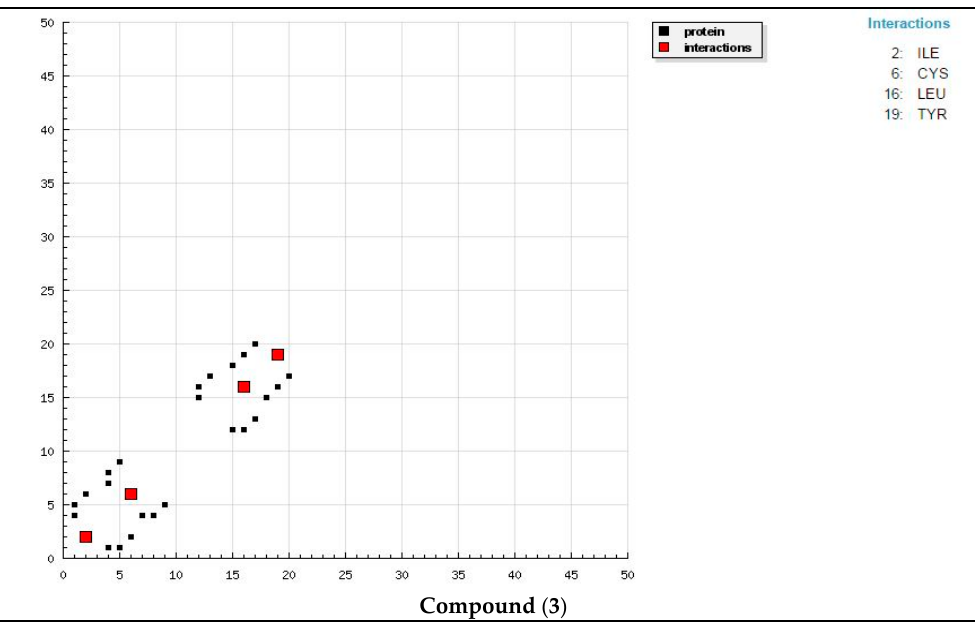
Figure 6. HB plot of interaction between spiropyrazoles products with receptor of breast cancer mutant 3tt8.